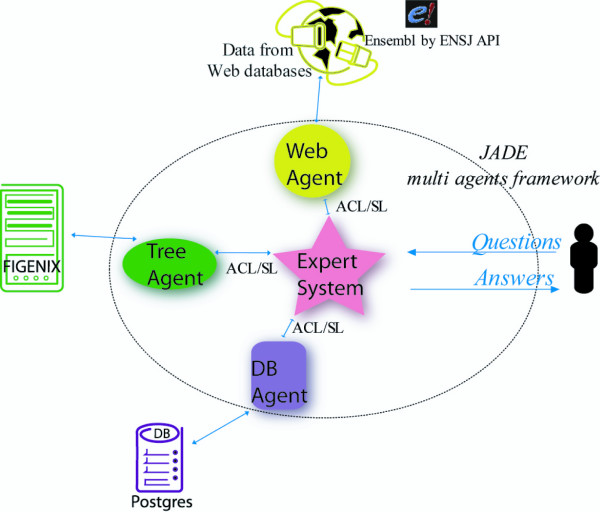
CASSIOPE multi-agent system, showing all the agents and the communications (blue) between them, together with non-system elements. Pink: Expert System; Violet: persistence agent and Postgres database; Green: tree agent and FIGENIX platform; Yellow: Web agent.